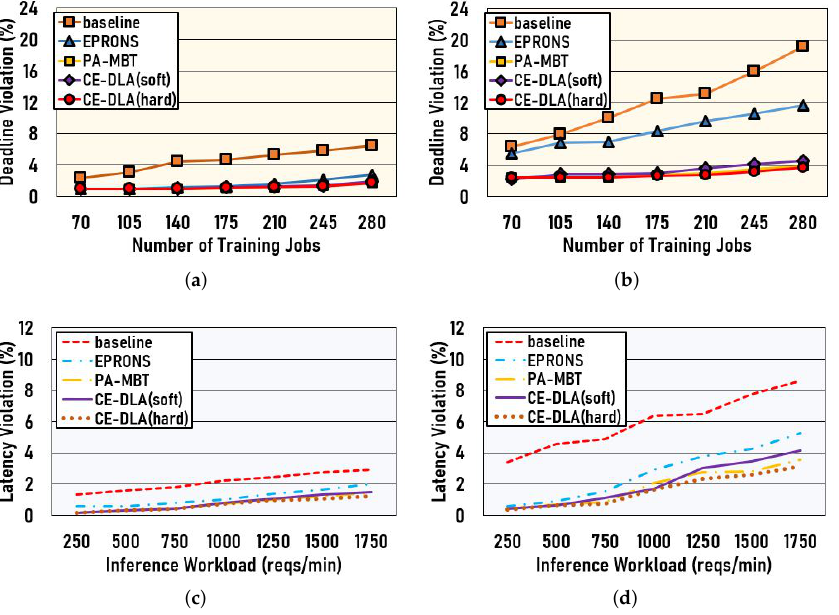
Figure 4. Deep learning (DL) training job deadline violation and inference job response latency bound violation. Inference workload of ( a ) = 1 × 10 5 and ( b ) = 1.75 × 10 5 (reqs/min). Training jobs of ( c ) = 175 and ( d ) =